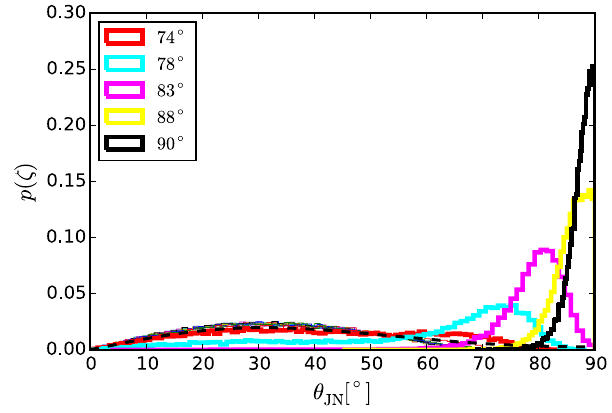
FIG. 8. The same as Fig. 2, but for source A